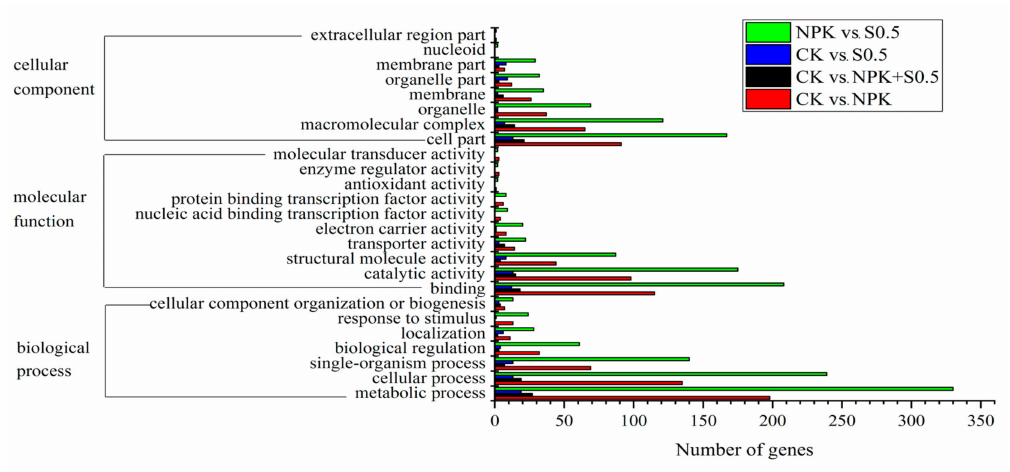
Figure3. Statistical classification of gene ontology (GO) annotation for di ff erentially expressed genes